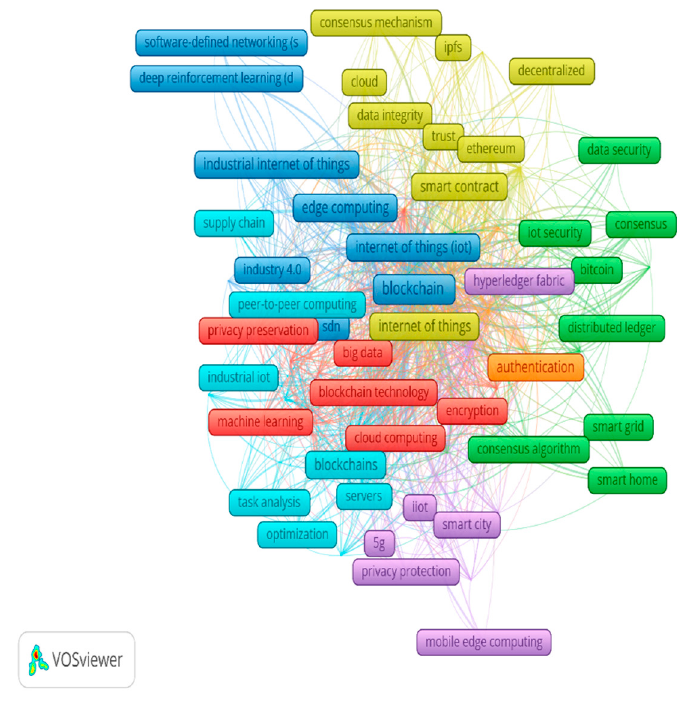
Figure 5. Bibliometric map created based on author keywords co-occurrence using network visual- ization of VOSviewer.